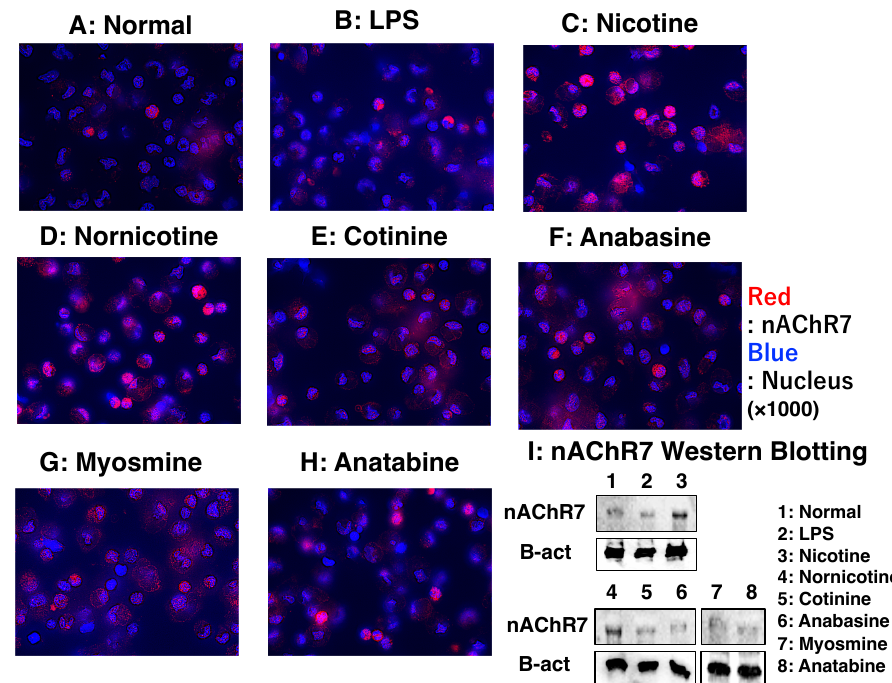
Figure 10. nAChR7 expression in rat peritoneal M Φ at the protein level. ( A ) Results of FICS of nAChR (red fluorescence) in normal rat M Φ (no stimulation). ( B – H ) Results of FICS of nAChR in rat M Φ treated with 10 µ g/mL LPS, nicotine, nornicotine, cotinine, anabasine, myosmine, and anatabine, respectively. DAPI-stained nuclei exhibit blue fluorescence. All microscopic images were observed using a BIOREVO BZ-9000 microscope (Keyence Co., Ltd., Osaka, Japan). Super-high-power magnification was used for all panels ( × 1000). ( I ) Western blotting was performed to detect nAChR7 expression in each stimulated M Φ . The upper and lower panels show the expression of nAChR7 and β -actin (an internal control) proteins, respectively. Lane 1 shows the nAChR7 expression in normal rat M Φ (no stimulation). Lanes 2–8 indicate nAChR7 expression in rat M Φ stimulated with 10 µ g/mL of LPS, nicotine, nornicotine, cotinine, anabasine, myosmine, and anatabine, respectively. FICS, fluorescent immunochemical staining; LPS, lipopolysaccharide; M Φ , macrophages; and nAChR7, α 7 nicotine acetylcholine